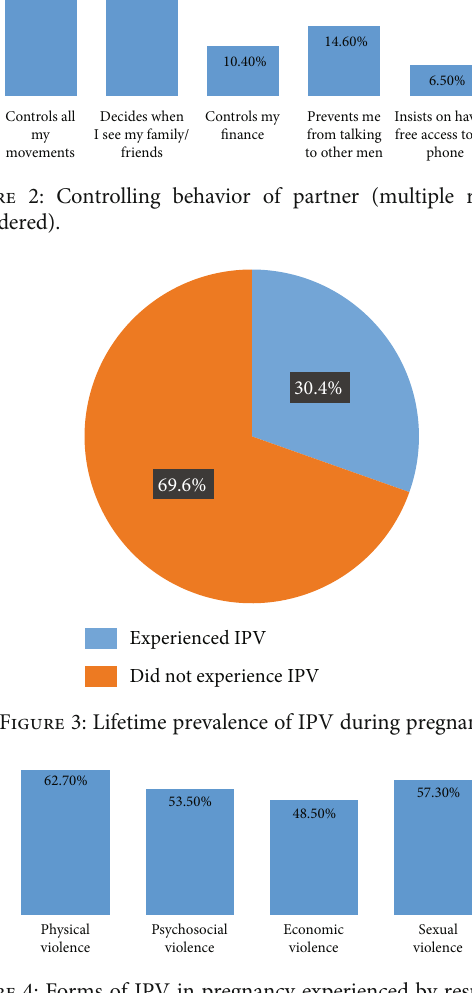
Figure 4: Forms of IPV in pregnancy experienced by respondents (multiple responses